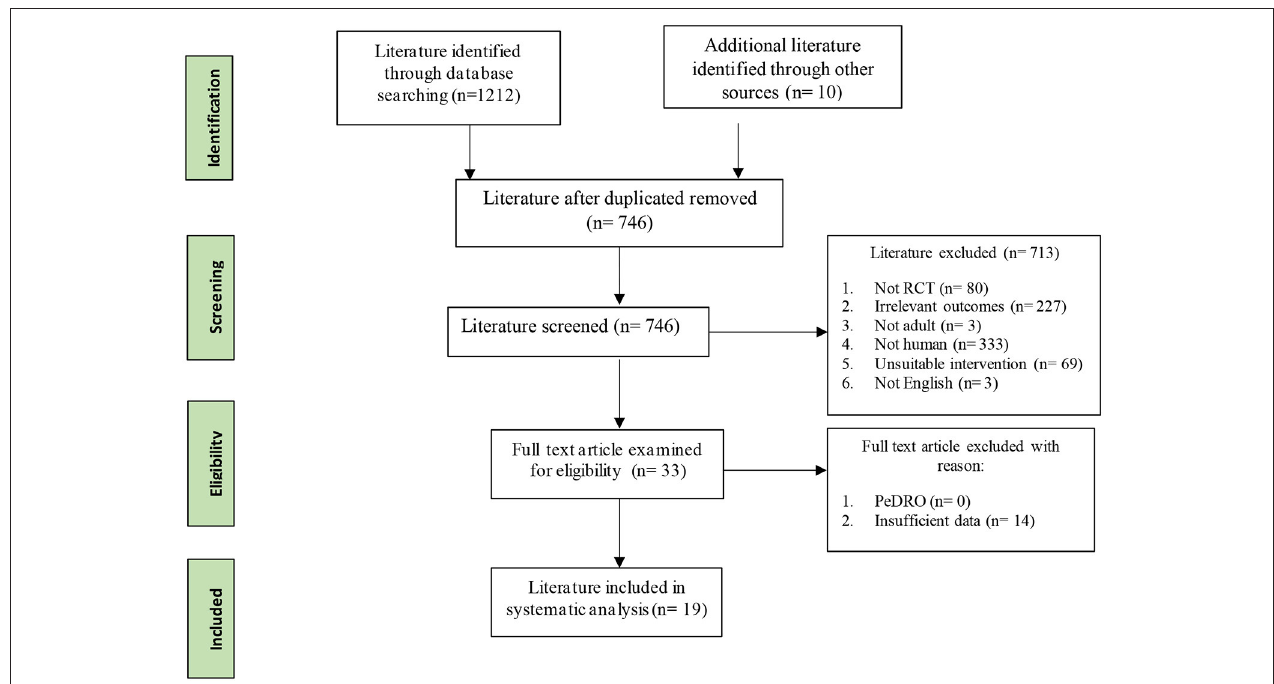
FIGURE 1 | PRISMA